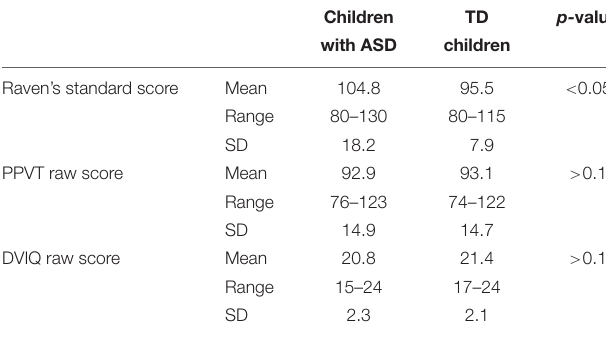
TABLE 1 | Baseline